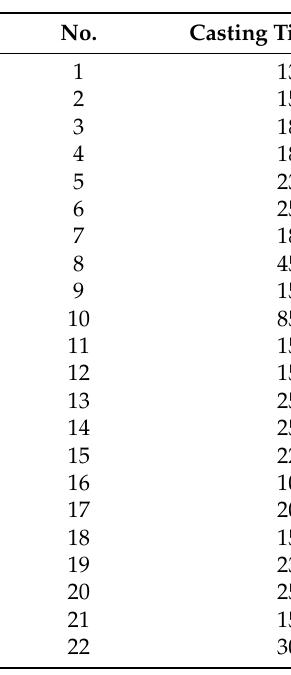
Figure 6. Change in maximum lateral pressure relative to casting height.